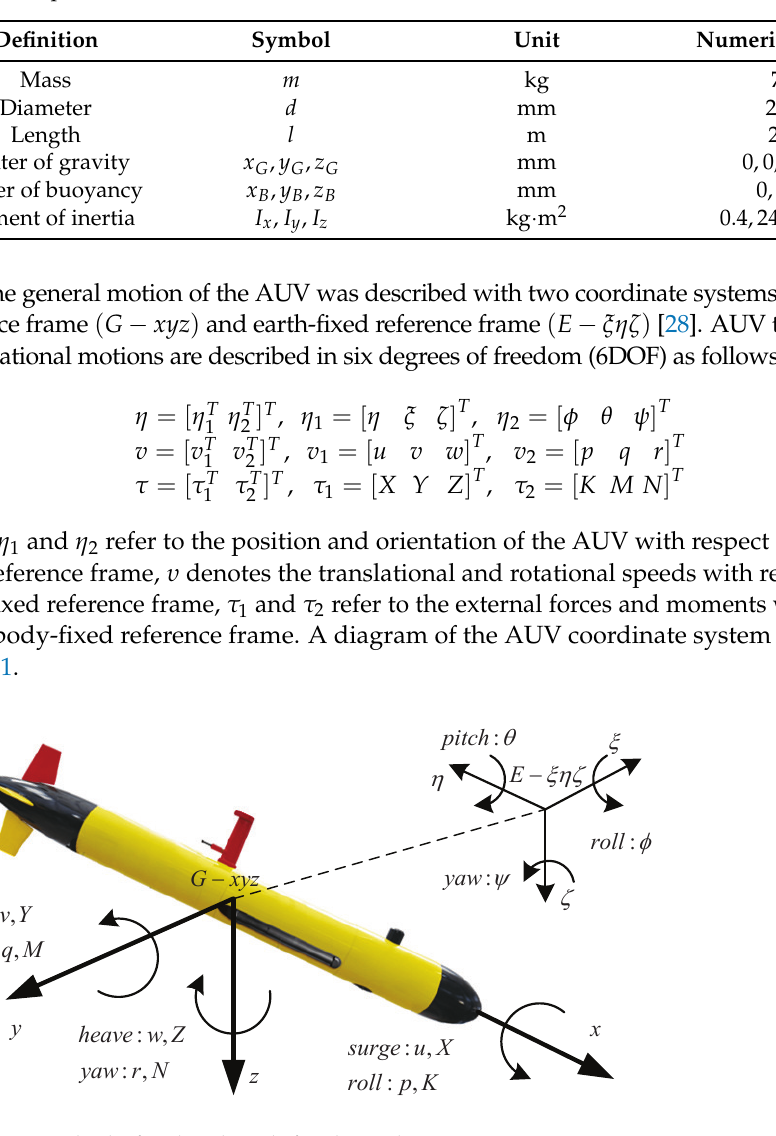
Figure 1. AUV body-fixed and earth-fixed coordinate